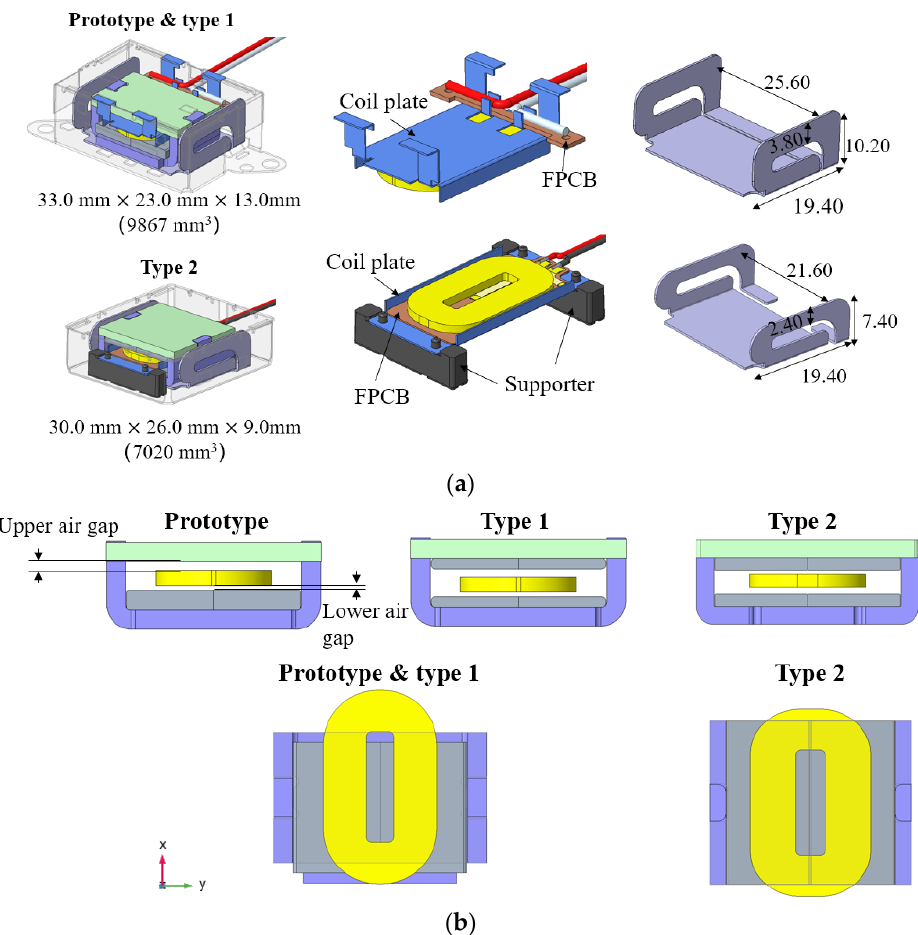
Figure 5. Prototype and new designs: ( a ) dimension and structure comparison and ( b ) the position of the type 2 coil.